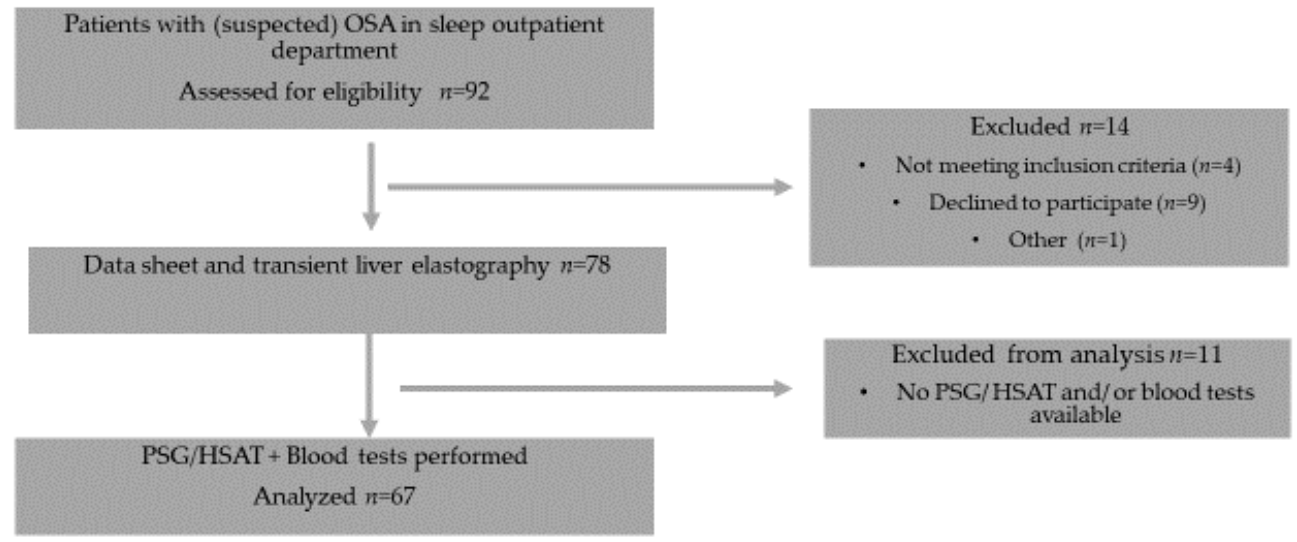
Figure 1. Consort flow diagram of the study protocol. Figure 1 . Consort flow diagram of the study protocol . Table 1. Demographic data and collected parameters.